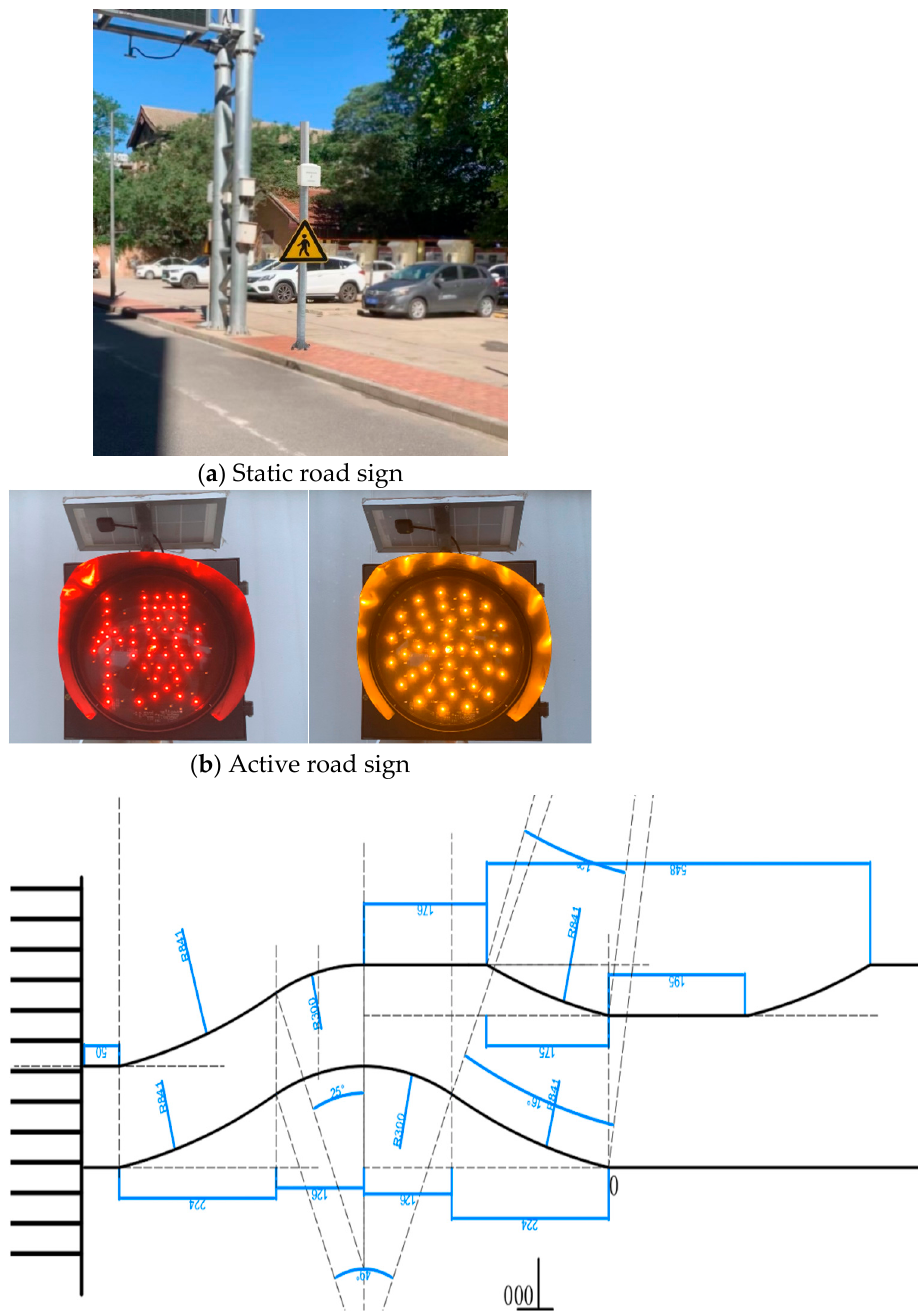
Figure 3. Tra ffi c calming measures. Figure 3. Traffic calming